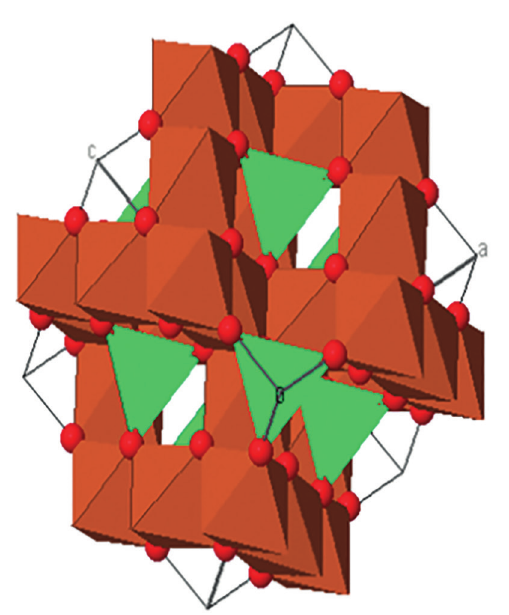
Cu Fe O 0.50 0.50 2 4